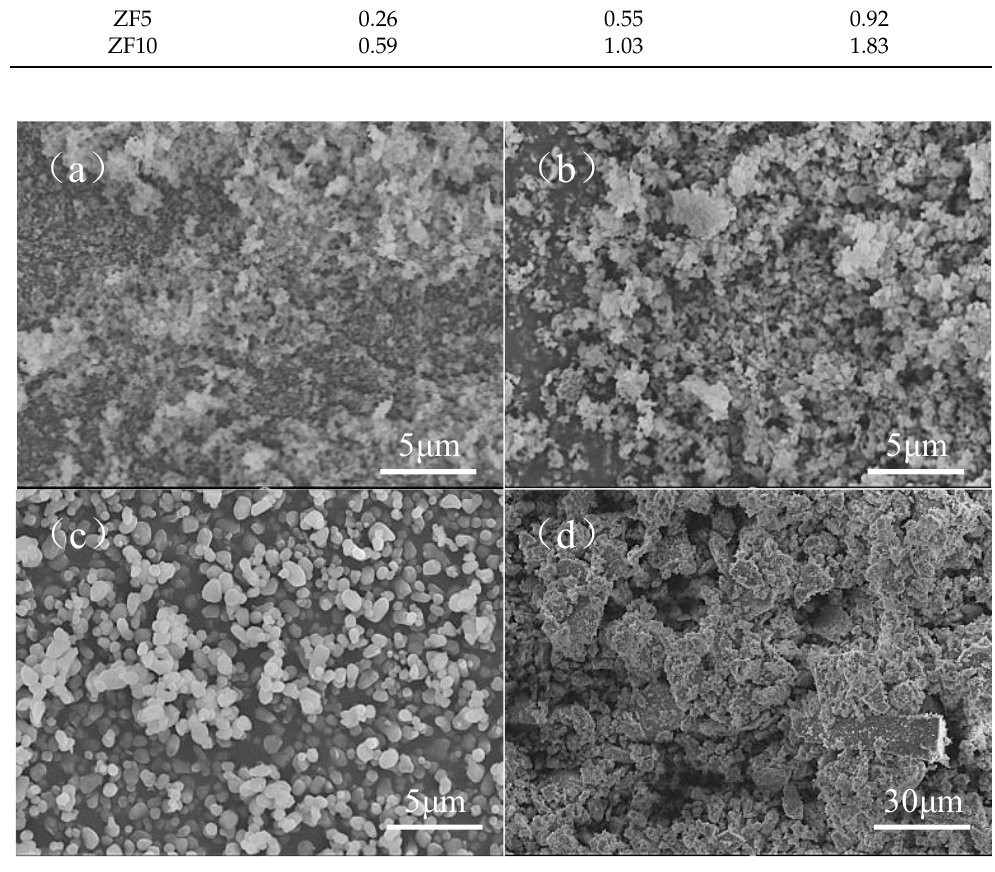
Figure 1. SEM images of powders with different particle sizes: ( a ) d50 = 0.21 μm , ( b ) d50 = 0.55 μm , ( c ) d50 = 1.03 μm , ( d ) 200 mesh.